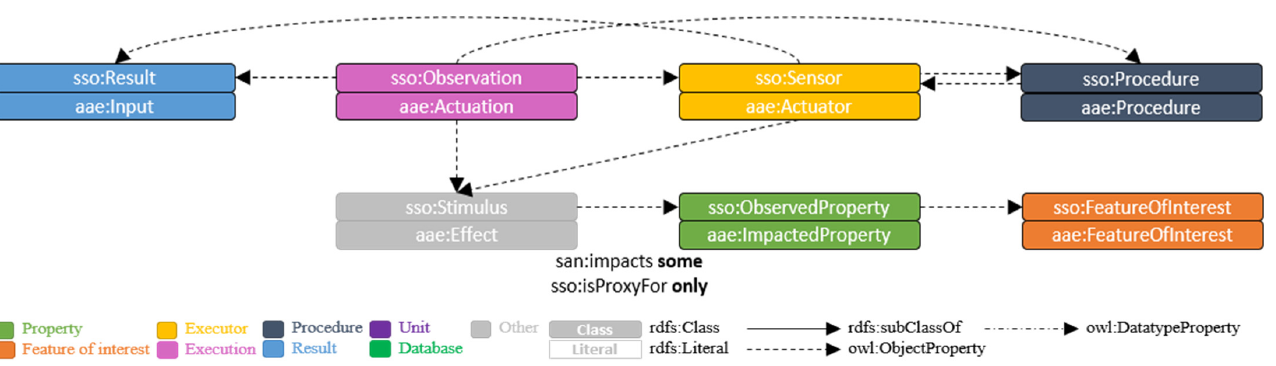
Figure 8. The TDO pattern extends eep:Execution with tdo:Event. The ThinkHome [35] ontology introduces various property classes. “Parameter” describes outdoor environmental properties, “BuildingParameter” describes properties of the building, and EquipmentParameter describes properties related to technical equipment, such as HVAC. None of these classes are linked with the BuildingElement class, narrowing the scope for describing building control-related parameters and risking possible irregularities between the various parameter classes. The sensor ontology of OntoFM [54–56] used a different approach. The ontology, which is based on OntoSensor, does not introduce a property class. Instead, a taxonomy of subclasses of the sensor class is introduced, indicating the property which is measured by the sensor (Figure 9). The sensor itself is directly linked to a building entity it measures. For example, a motion sensor could be linked to an opening in a wall. Although this reduces the size of the graph, it introduces unintuitive SPARQL constructs for basic competency questions. Figure 9. The absence of properties in OntoFM. SEAS [94] also introduces a dynamic property pattern (Figure 10). It narrowed down DUL’s definition of dul:Quality by stating that a property should be an observable or operable quality of an event or object. This specification is common in the context of dynamic properties since the ontologies often describe typical time-series information which is observable by sensors. The term “observable” is, however, rather loosely defined, as one could argue that static properties (such as color and length) are also observable.